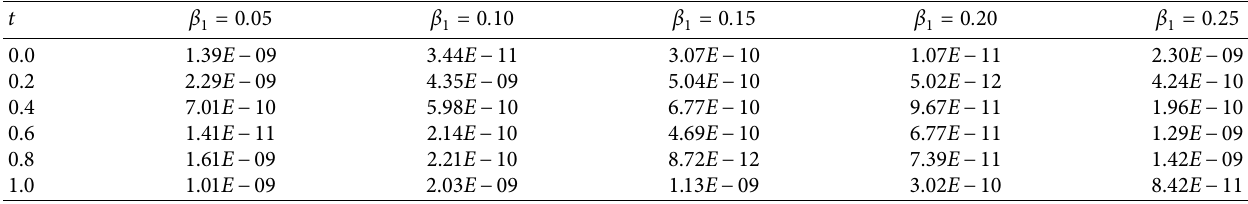
Table 16: Absolute errors obtained by the LeNN-WOA-NM algorithm for population density of immigrant prey X ( t ) under the influence . of β 1